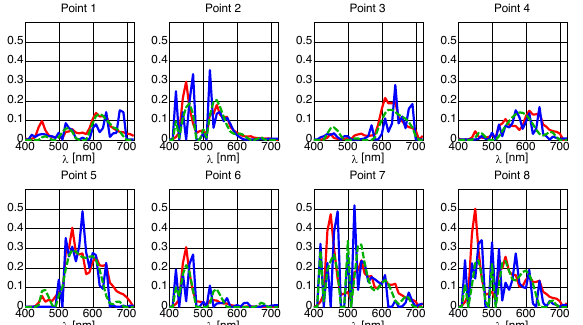
Figure 5. Spectra at chosen pixels of reference (red), 2D framelet (blue) and 3D wavelet reconstructed (dashed green) of the “Color Checker” with the 33 spectral bands in the range of 400nm-720nm. Position of pixels as in Figure 3(b).